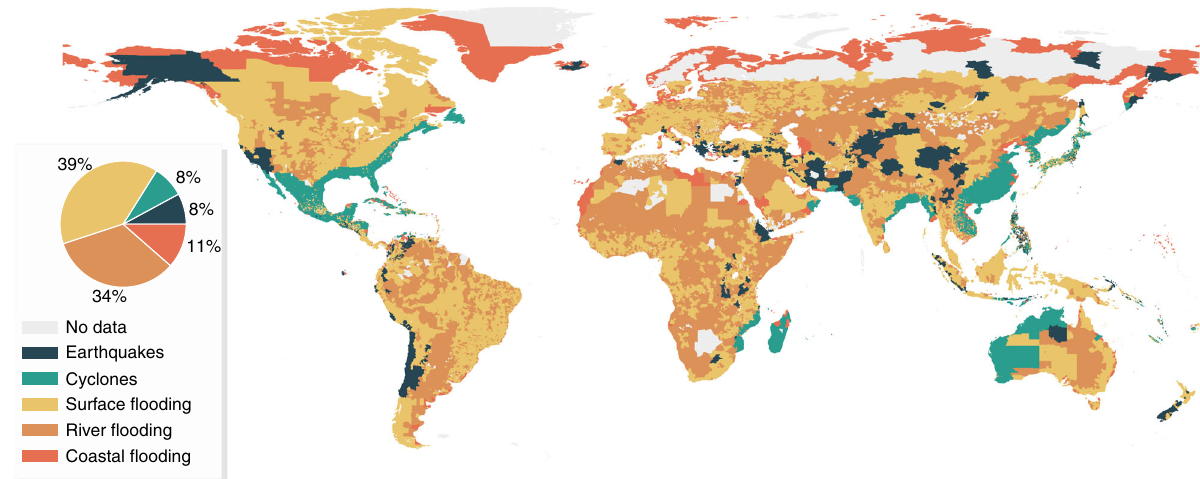
Fig. 2 Dominant hazard per region. This fi gure presents the hazard causing the highest transport infrastructure exposure in each region. The pie chart shows the relative percentage of land area (excluding areas with insuf fi cient data) where that speci fi c hazard causes the highest exposure